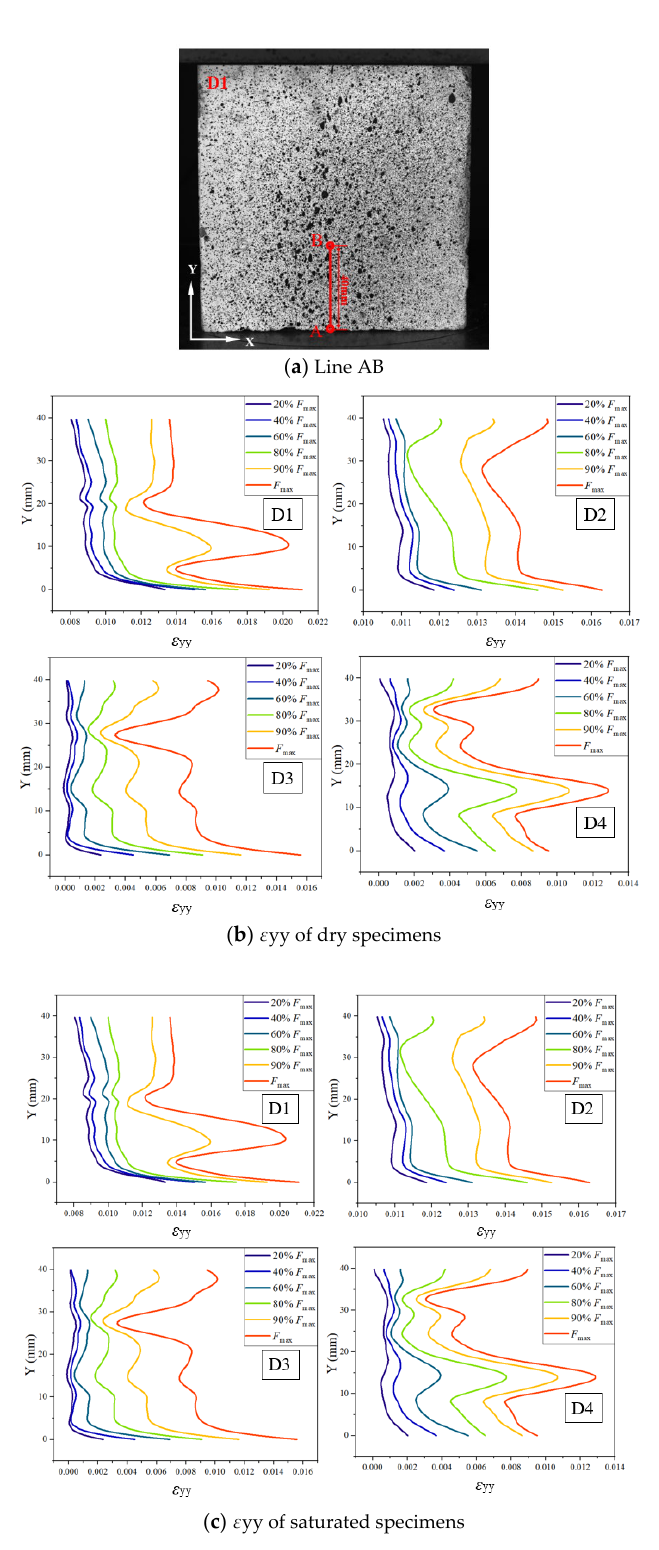
Figure 3. Variation of vertical strain of concrete with different moisture content. Therefore, under the effect of inertia, the stress of the loading end of the specimen was larger than the fixed end. To reveal the effect of inertia on the dynamic response of concrete, theoretical analysis and numerical simulation are